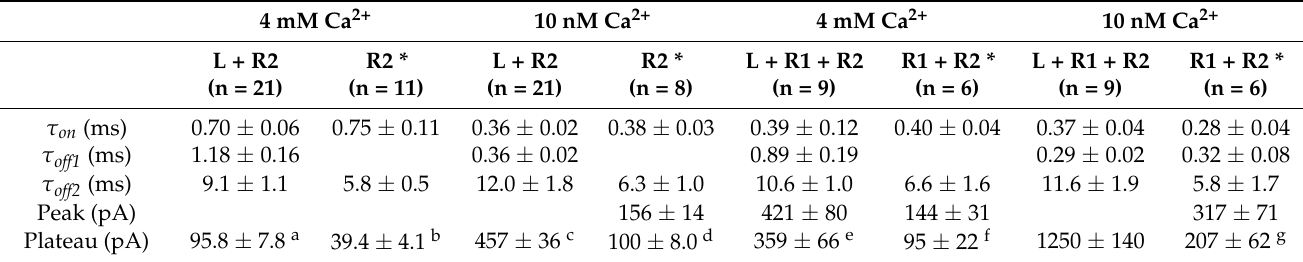
Table 1. Waveform parameters of Ca 2+ and cation currents in the control and in 10 µ M nifedipine.